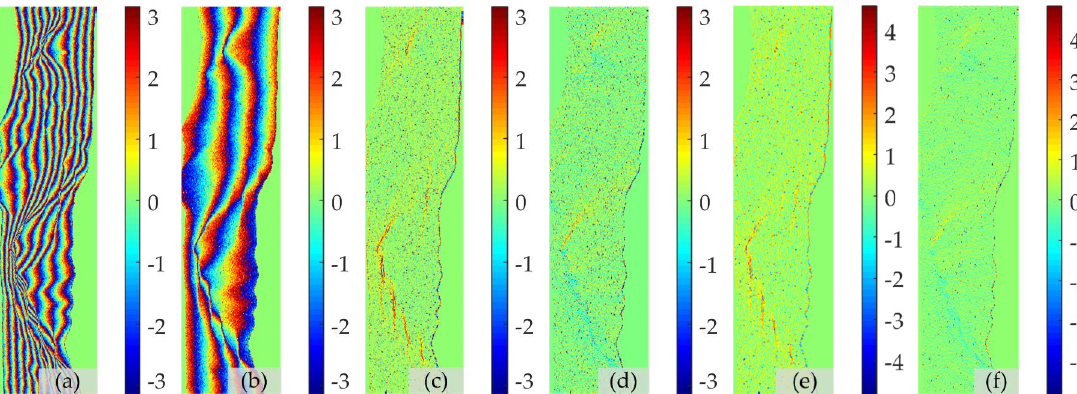
Figure 1. ( a ) Simulated interferogram with long normal baseline. ( b ) Simulated interferogram with short normal baseline. ( c ) Horizontal gradient obtained by the single-baseline (SB) phase unwrapping (PU) of (b). ( d ) Vertical gradient obtained by the SB PU of (b). ( e ) Horizontal gradient obtained by the two-stage programming approach (TSPA) of (b). ( f ) Vertical gradient obtained by the TSPA of (b).